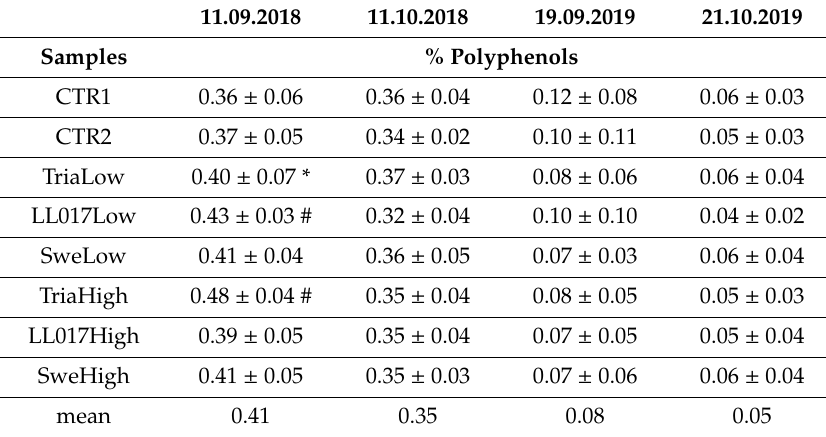
Table 5. Polyphenol contents from di ff erent harvests (11.09.2018, 11.10.2018 first year, 19.09.2019, 21.10.2019 second year) for each treatment. Values expressed are means ± S.D. of three